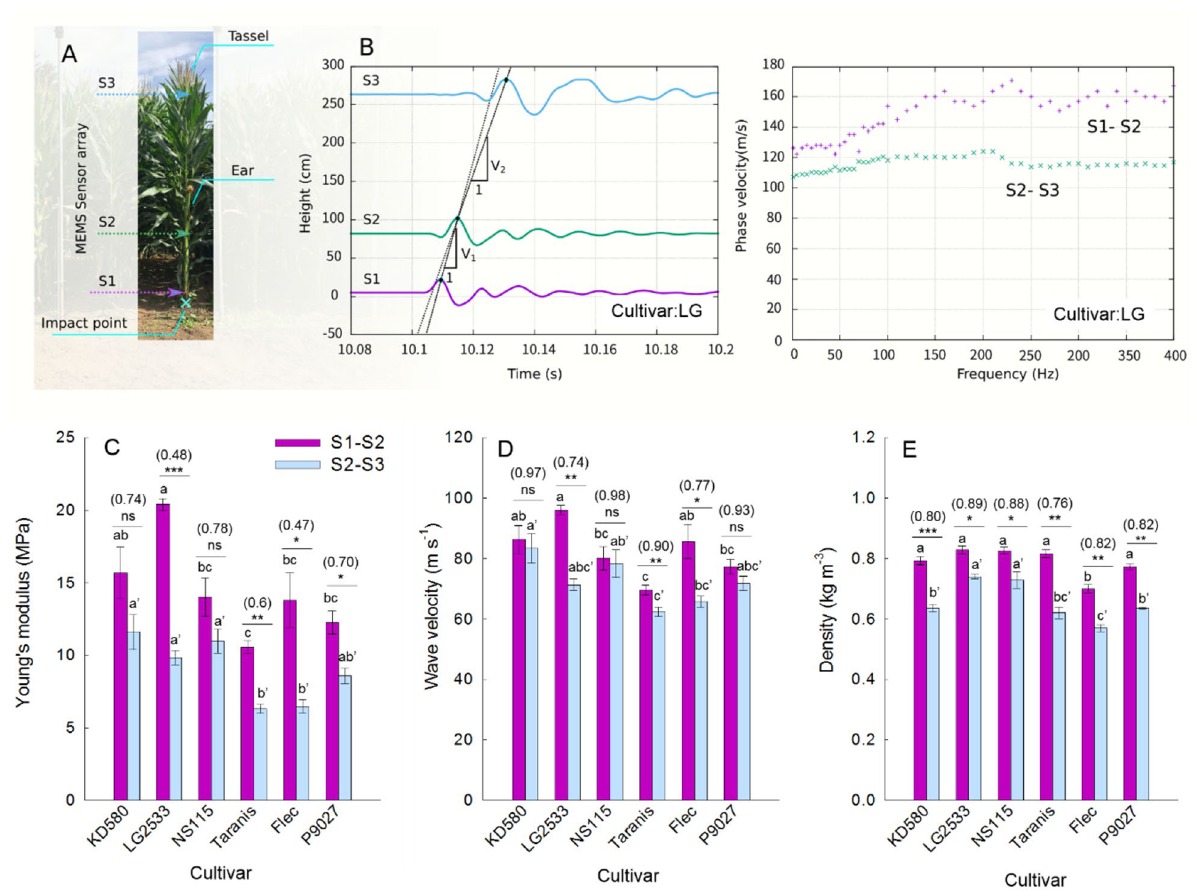
Figure 2. Record section and Young’s modulus of the vibration data associated with the impact test: ( A ) Position of the micro-electro-mechanical systems (MEMS) sensor array attached to the matured maize plant (cv. LG2533). An impulsive load wave was applied at the bottom of the stem to generate the surface shear waves. ( B ) Travel time curve for the shear wave (left) across the maize surface (cv. LG2533) and the dispersion curve (right). The travel time curve (solid line) clearly exhibits the different wave velocity in the stem, V1 between S1 to S2 and V2 between S2 and S3. Dispersion curve indicates the presence of a Lamb wave in section S1 to S2, while very small dispersion is present in section S2–S3. ( C ) Young’s modulus estimated by V 1 and V 2 based on the linear elasticity. ( D ) Wave velocities and ( E ) stalk densities below (S1–S2) and above (S2–S3) the ear for different cultivars. Values in C–E are means ± se (n = 4). Tukey’s HSD test was used to examine the statistical significances at p < 0.05 and different alphabets indicate significant differences. *, **, and *** in ( C )